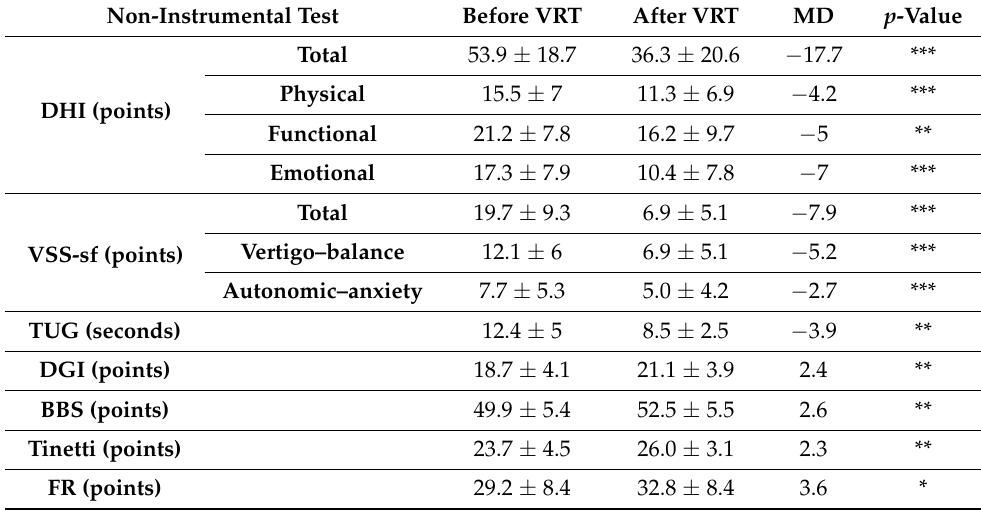
Table 2. Results of non-instrumental